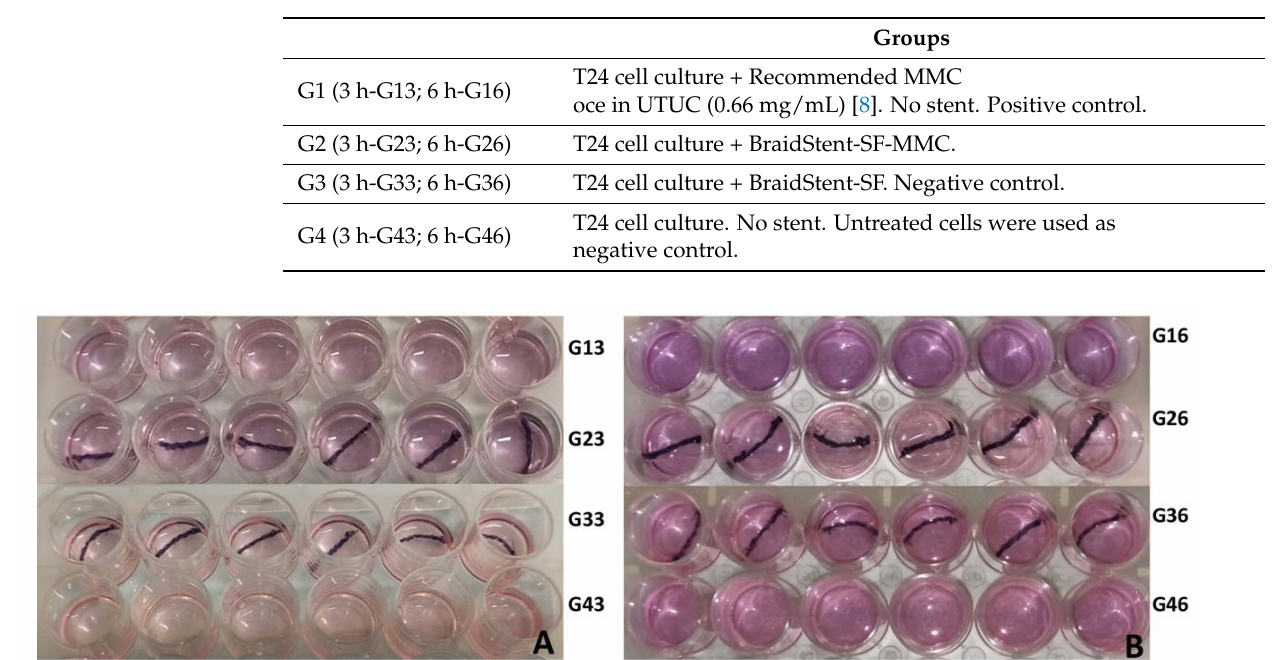
Table 1. Experimental study groups.